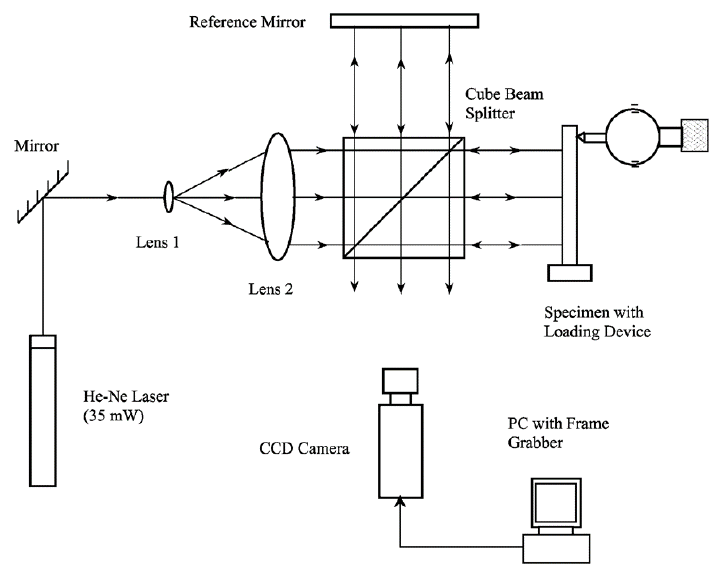
Figure 7. Schematic of experimental setup of ESPI. Non-destructive characterization of resin-based filling materials using electronic speckle pattern interferometry. Adapted with permission from Ref. [100]. 2019, Elsevier.